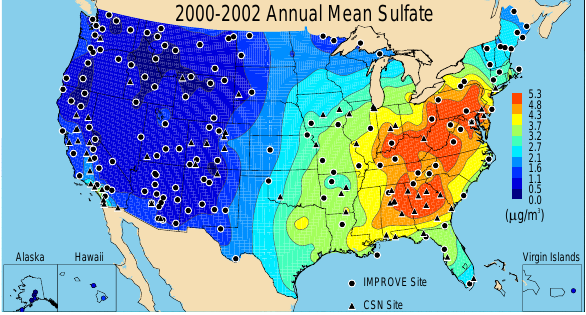
Fig. 2a. IMPROVE and CSN 2000–2002 annual mean particulate sulfate ion concentrations. Circles correspond to IMPROVE sites and triangles correspond to CSN sites.